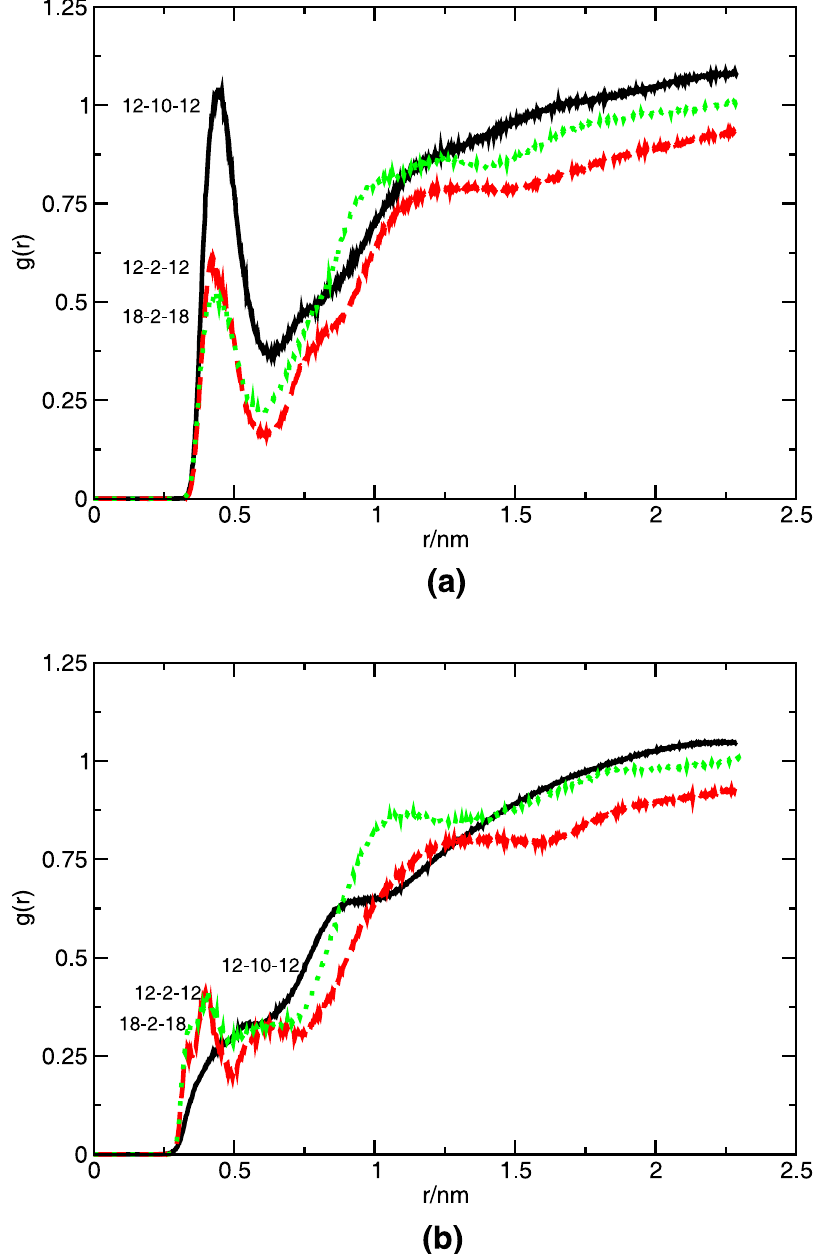
Figure 11. Radial distribution functions of water relative to the (a) gemini polar heads, and (b) gemini spacer, calculated from the MD. Simulations were carried out at 325